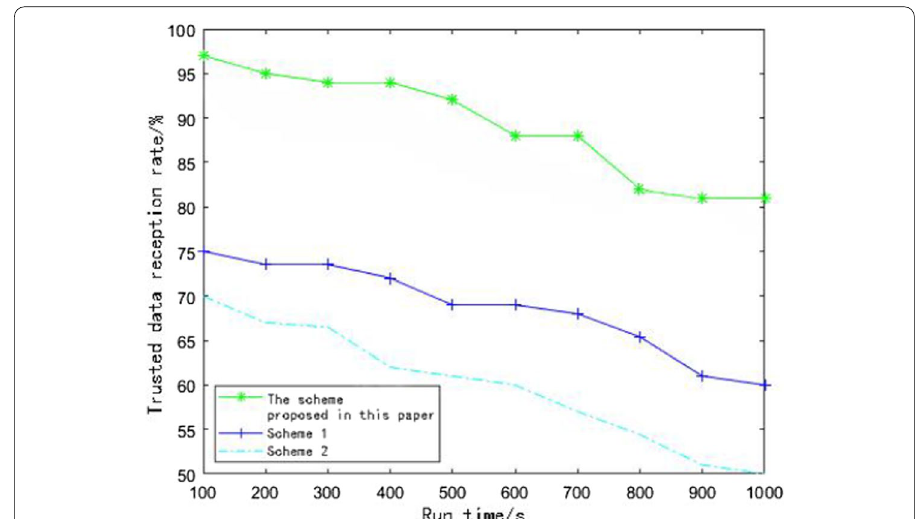
Fig. 4 The trusted data rate of the malicious nodes in 15%